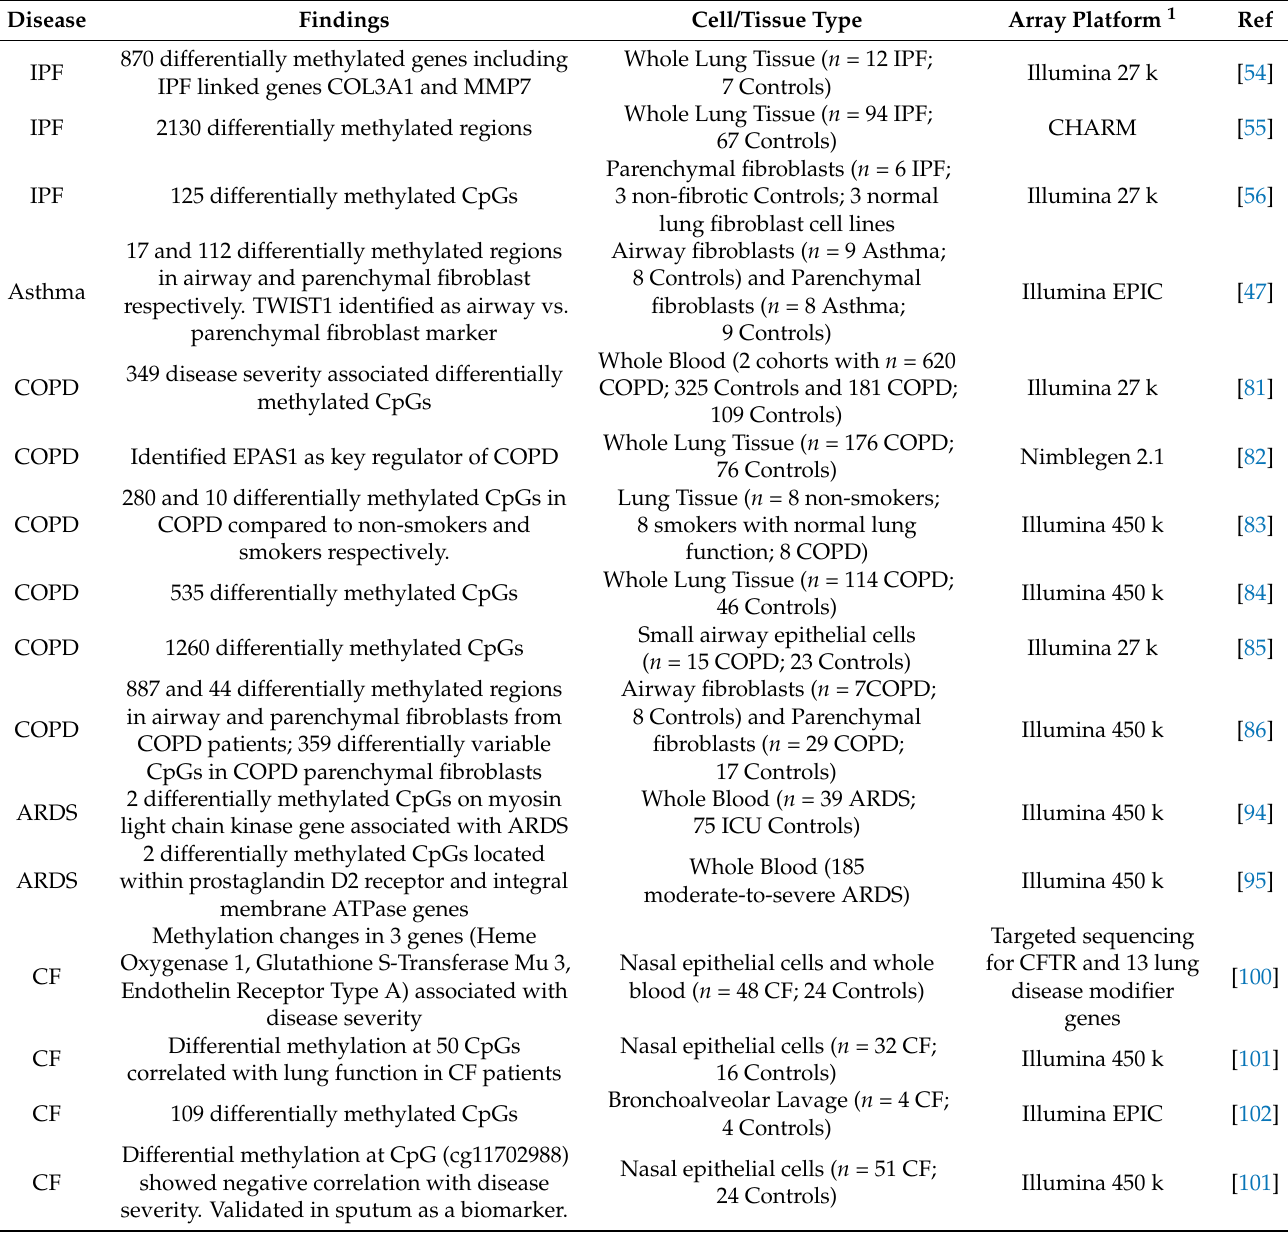
Table 1. Summary table of lung disease DNA methylation studies